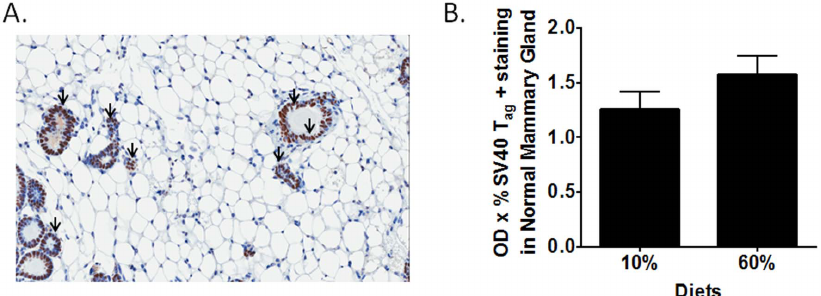
Figure 4. Normal mammary gland and tumor levels of SV40-T Ag are not increased by obesity in parous mice. A) Representative 20X photomicrographs of SV40 T-antigen (T Ag ) staining in normal mammary gland (A). Arrows indicate positive SV40 T Ag staining. B) SV40 T Ag levels in normal mammary glands (B) were quantified. n=2 sections from 5 mice per diet group were digitally quantified. *P=0.044.